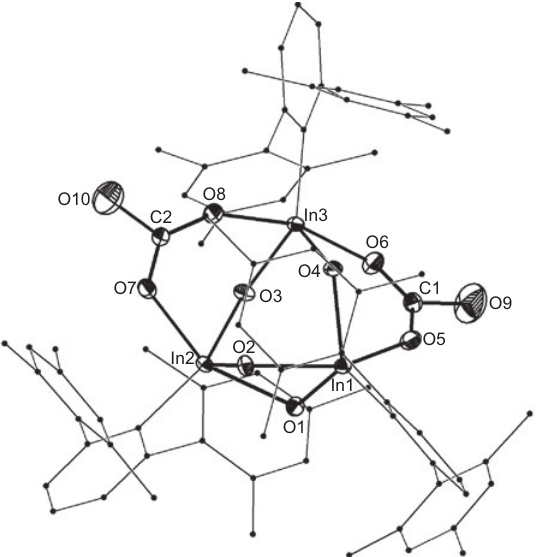
Figure 2 Molecular structure of 3 showing 20 % probability ellip- soids and the crystallographic numbering